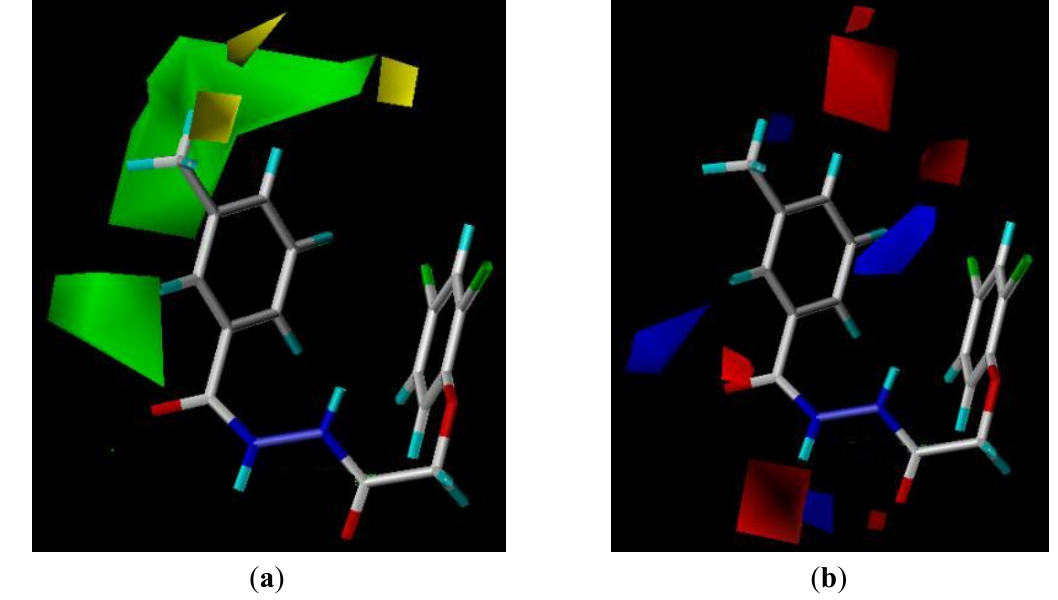
Figure 4. Steric and electrostatic contribution contour maps of